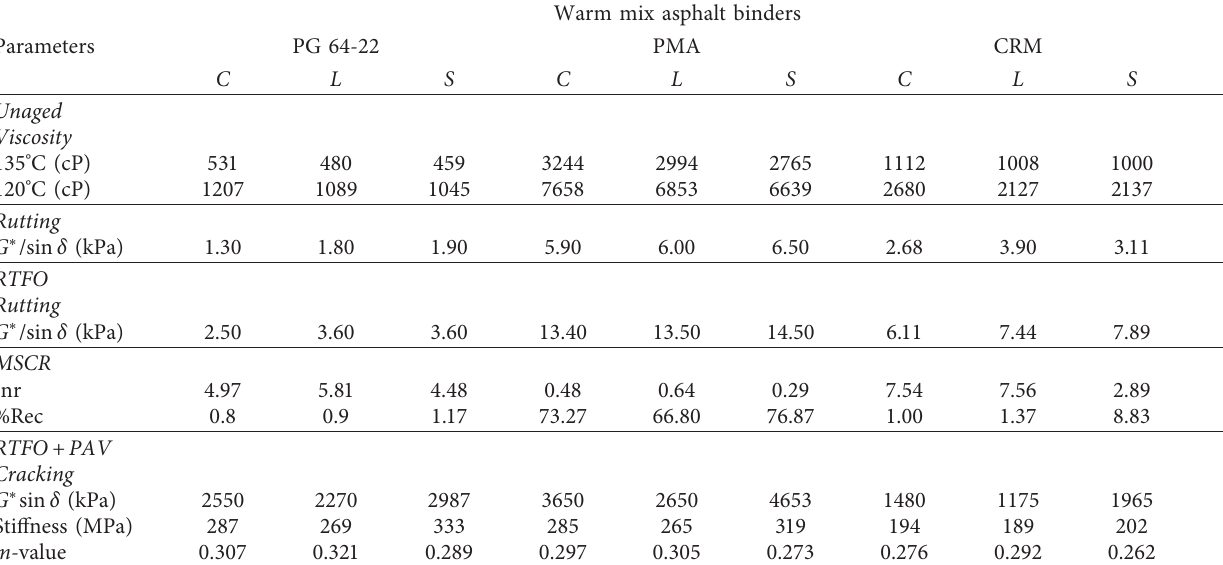
Figure 1: Wax additives. (a) LEADCAP and (b) Sasobit. Table 3: Physical and rheological properties of the WMA